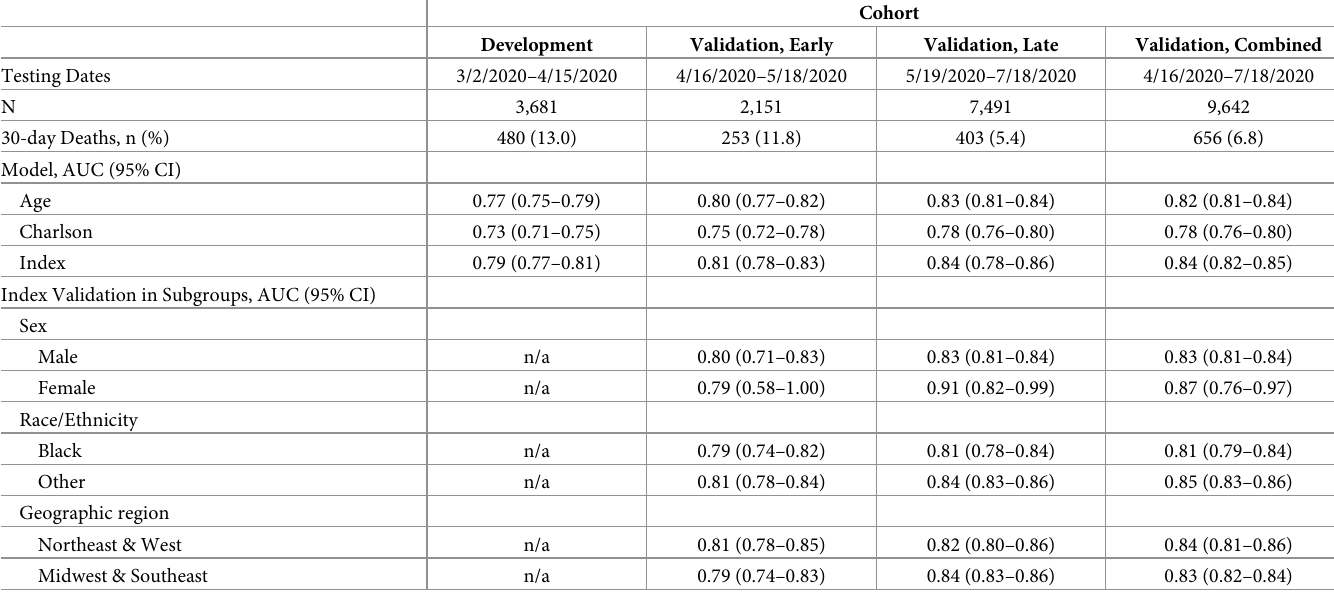
Table 3. Validation of VACO Index 30-day COVID-19 mortality estimates using area under the receiver operating characteristic